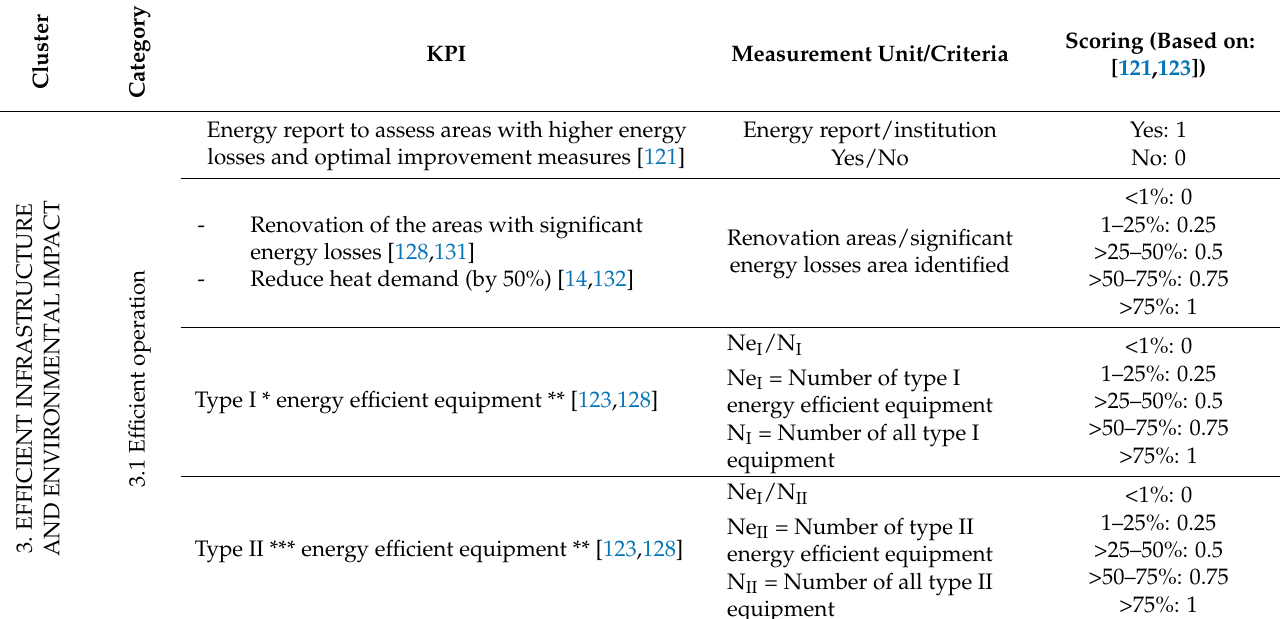
Table 3. KPIs for infrastructure assessment from the environmental impact point of